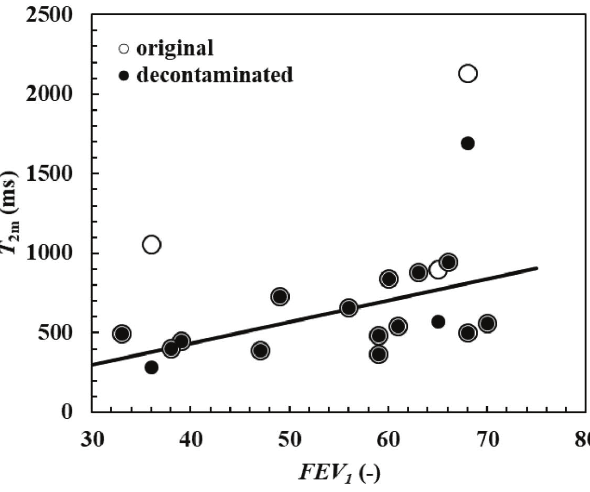
Fig. 8 – Correlation between the sputum average relaxation time (T ) and FEV (known for 17 out of 38 samples). open 2m 1 circles refer to T data not corrected for the possible saliva 2m presence (original), while closed circles represent corrected (decontaminated) T data. Straight line is the linear interpo- 2m lant evaluated on corrected data.